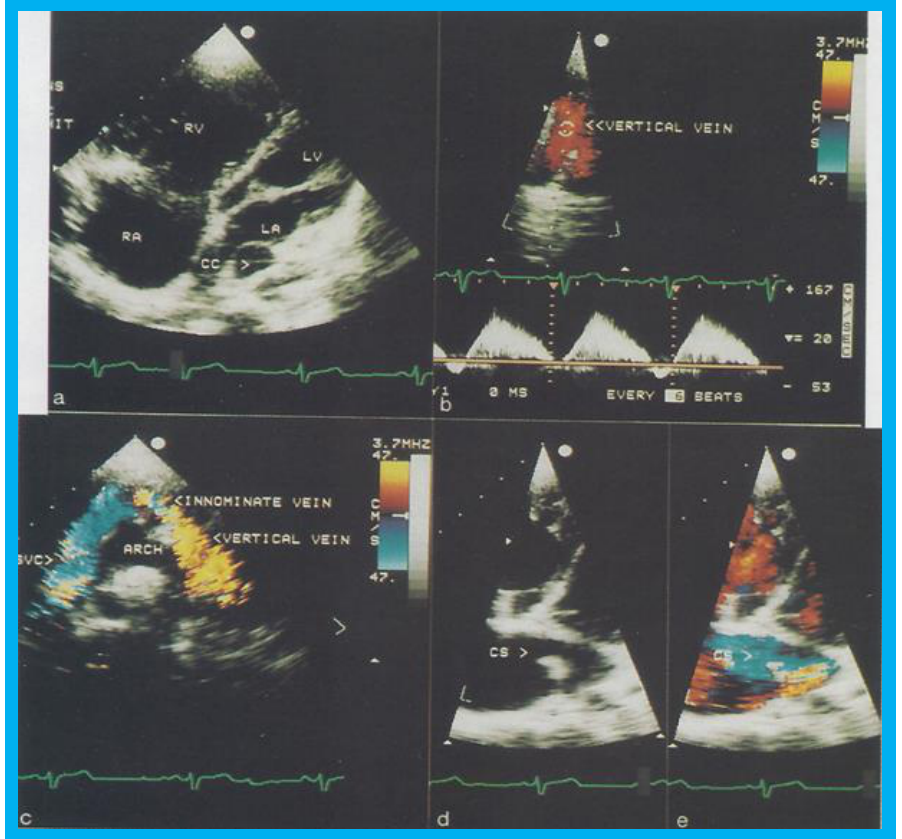
Figure 6. Selected two-dimensional ( a ) and color flow images ( b – e ) of a patient (case 1) with mixed type of total anomalous pulmonary venous connection are shown. In ( a ), dilated right atrium (RA) and right ventricle (RV) and common pulmonary venous confluence (CC) are illustrated. In ( b , c ), spectral and color flow images demonstrate the vertical vein draining into the innominate vein and superior vena cava (SVC). In ( d , e ), dilated coronary sinus (CS) with mosaic color flow pattern of pulmonary venous entry are apparent. ARCH, aortic arch; LA, left atrium; LV, left ventricle. Reproduced from Reddy S.C.B., et al. [8].